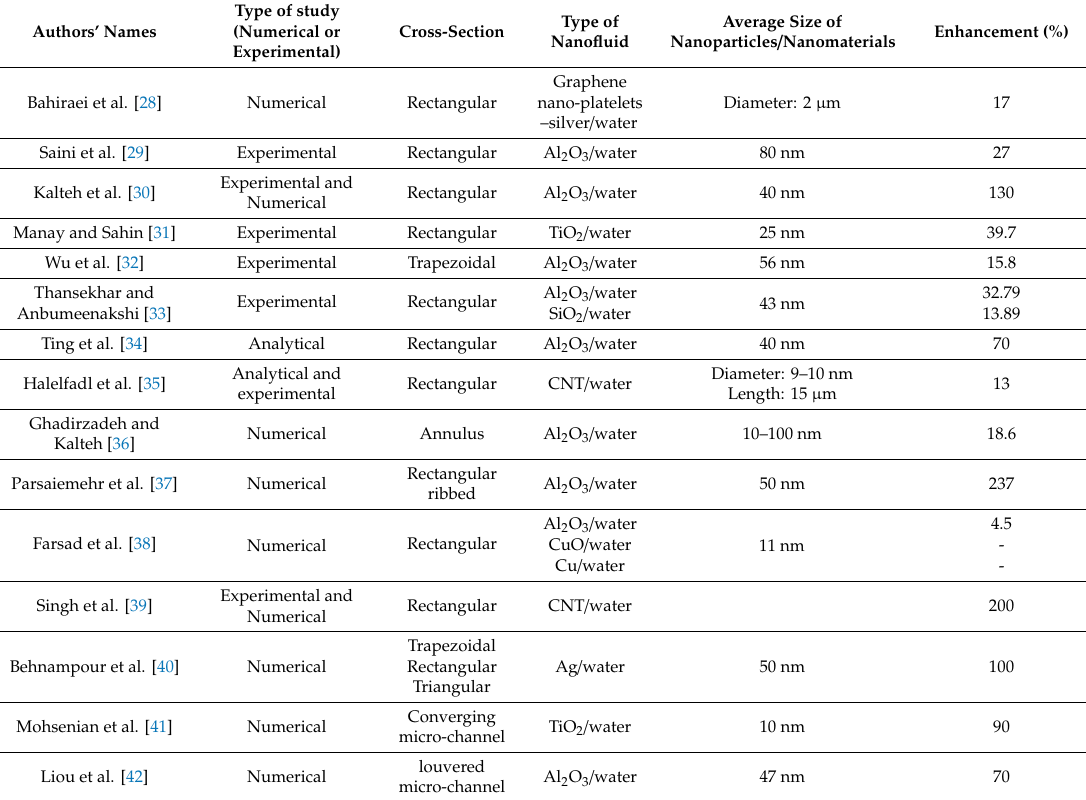
Table 1. A summary of works conducted on the thermal performance of the nanofluids in micro-channel heat-exchanging